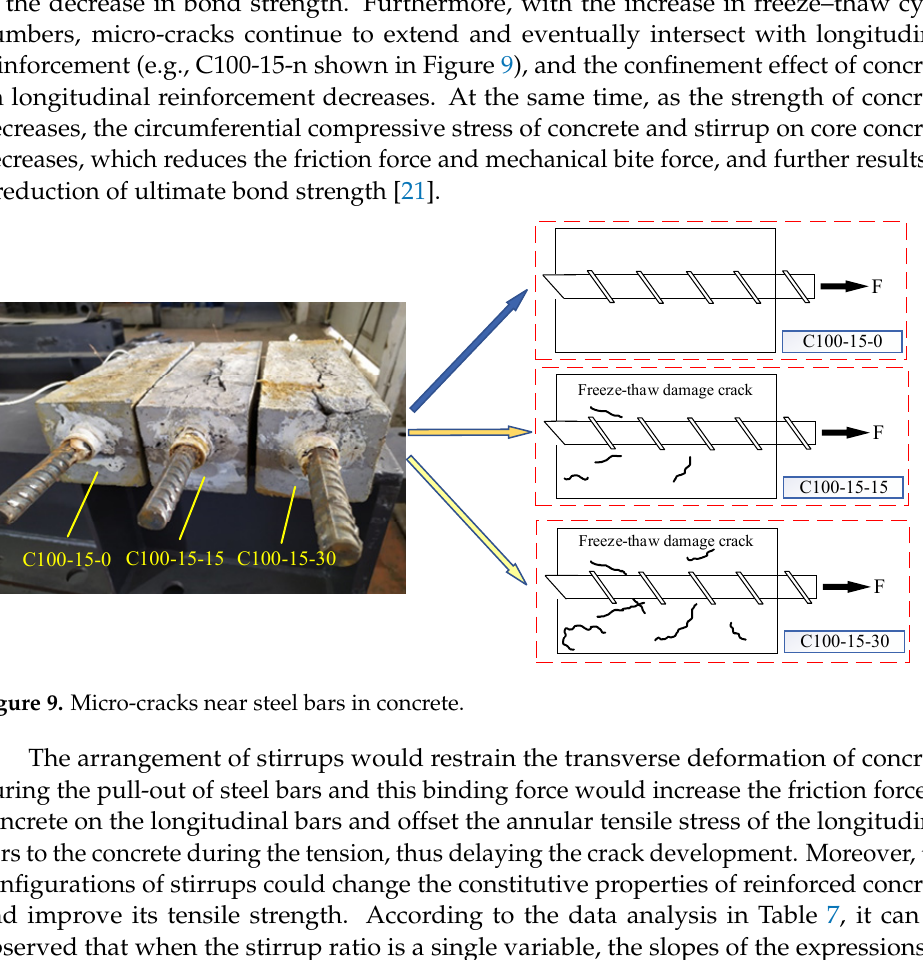
Table 7. The ultimate bond strength and ultimate slip as a function of stirrup ratio ρ sv .